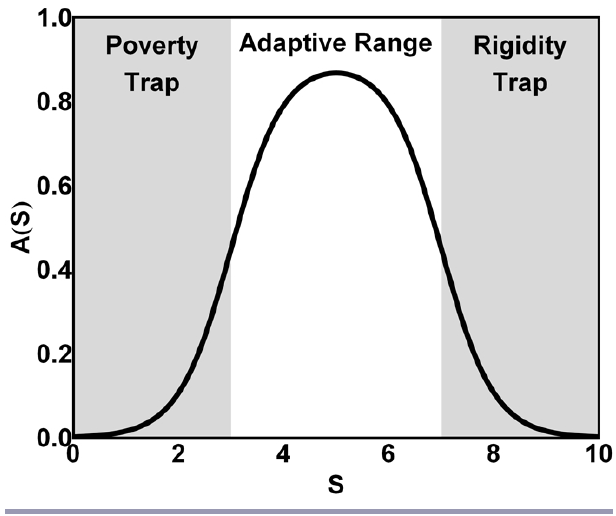
Fig. 2 . Adaptive capacity: A(S) as a function of cumulative stress, S, reproduced from Carpenter and Brock (2008) with